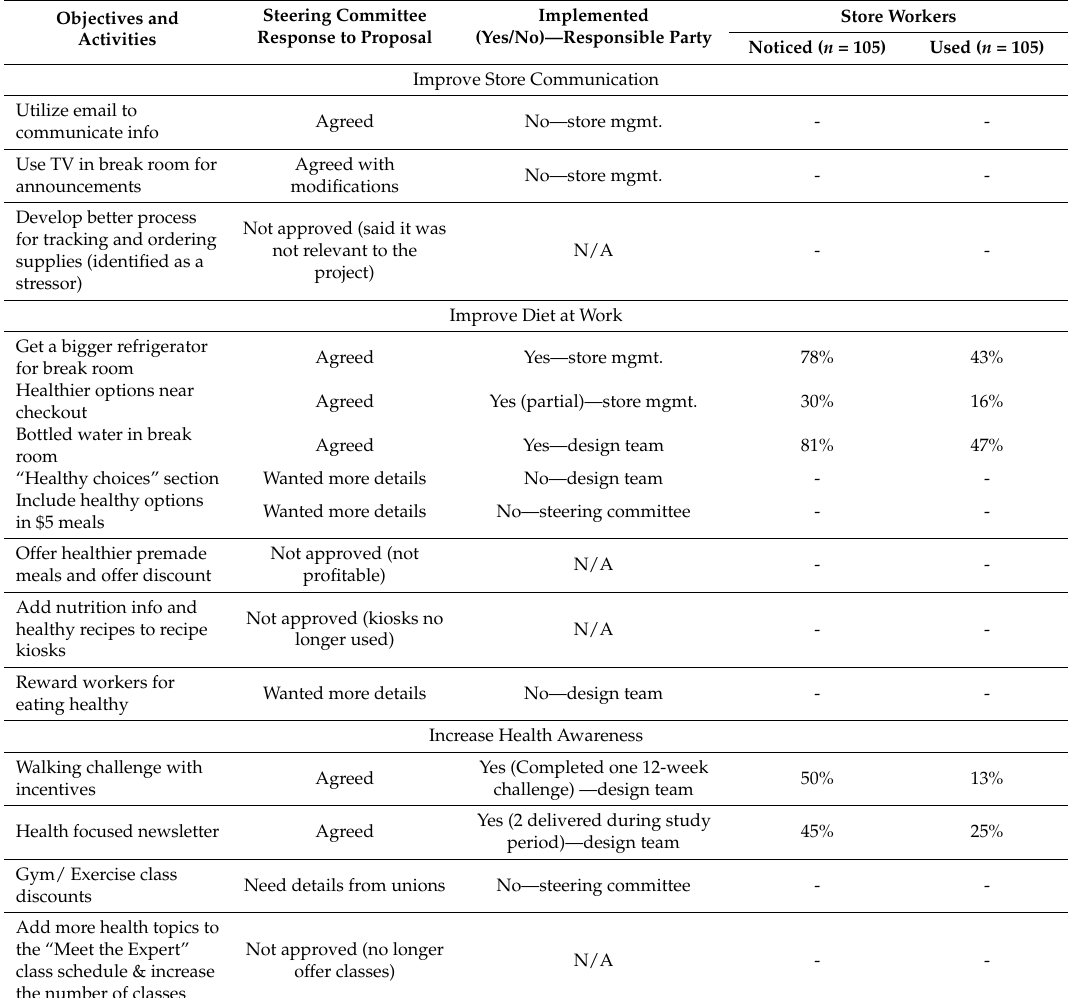
Table 3. Proposed activities and implementation